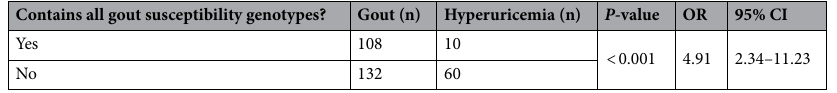
Table 5. Association between the number of susceptible genotypes and the risk of gout.